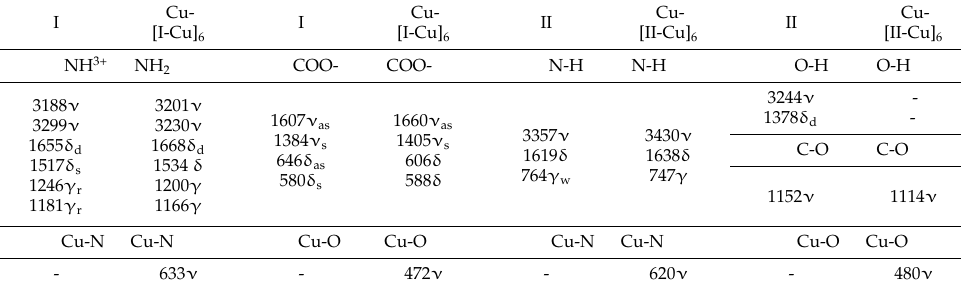
Table 5. Relevant IR bands for the compounds I and Cu-[I-Cu] 6